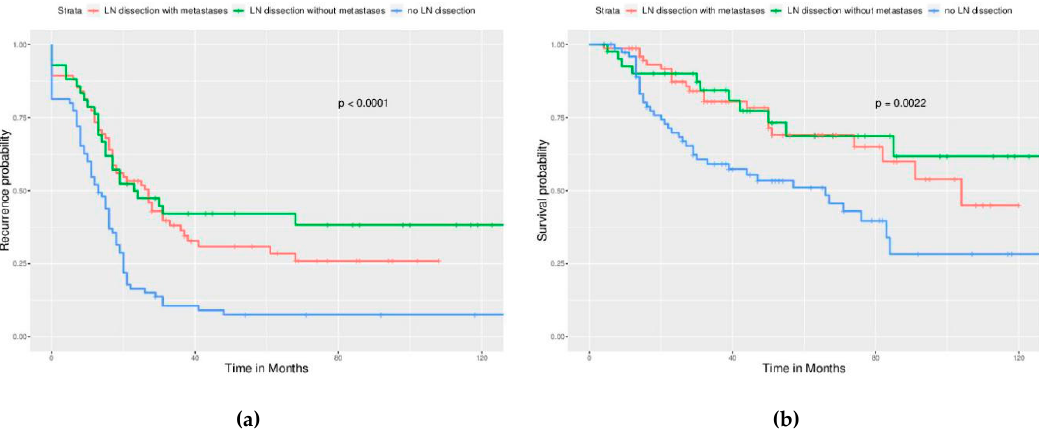
Figure 4. Survival curves by the LN status (All enrolled cases) ( a ) PFS, p < 0.0001, ( b ) OS, p = 0.0022. LN dissection provided better outcome of all enrolled cases, no matter how LN status was.